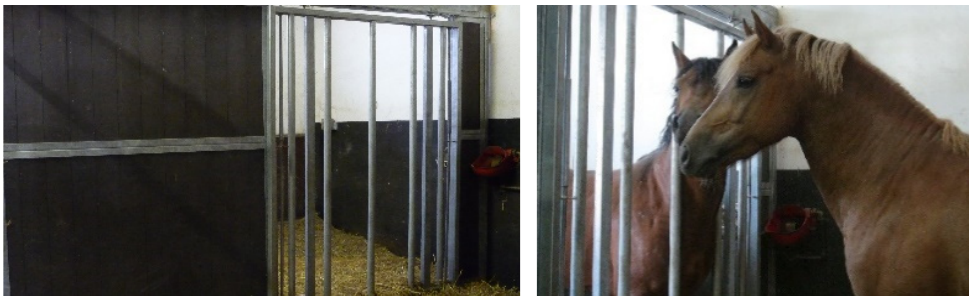
Figure 2. “Social box” stabling (SB) allows closer physical contact.